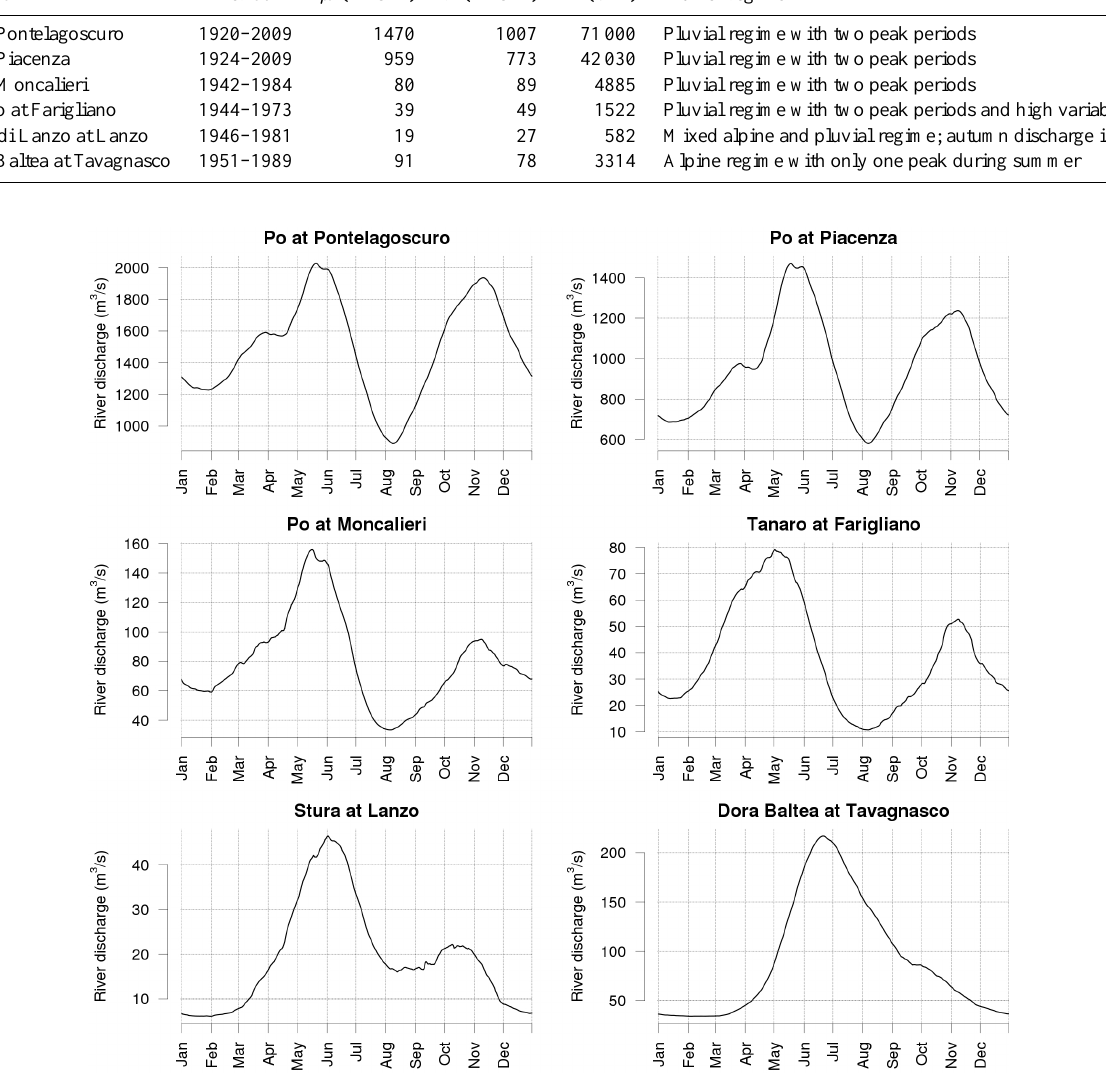
Fig. 4. Seasonal components for the considered time